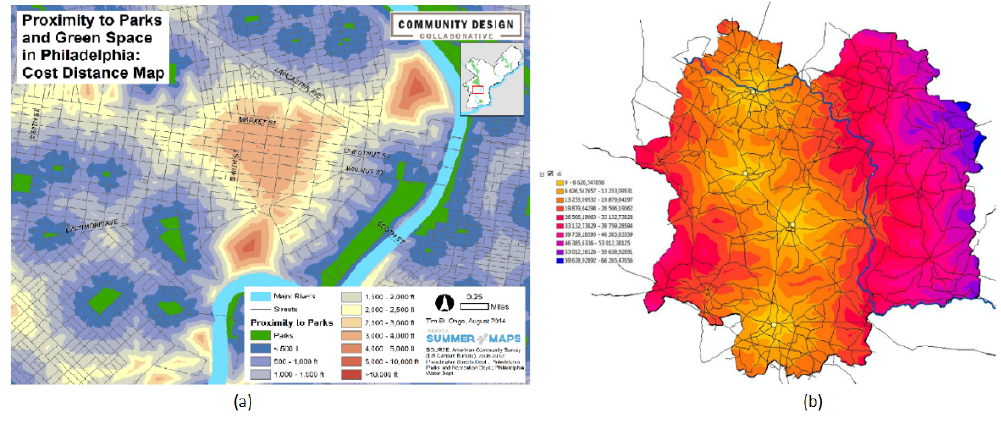
Figure 5. Determination of service areas in raster analysis: ( a ) [32]; ( b )